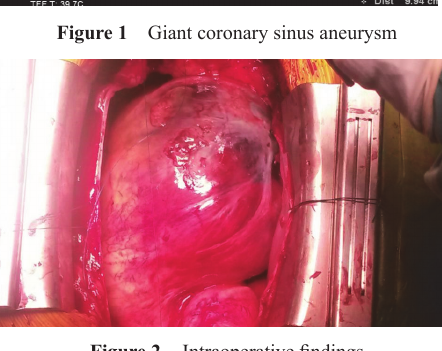
Figure 2 Intraoperative findings